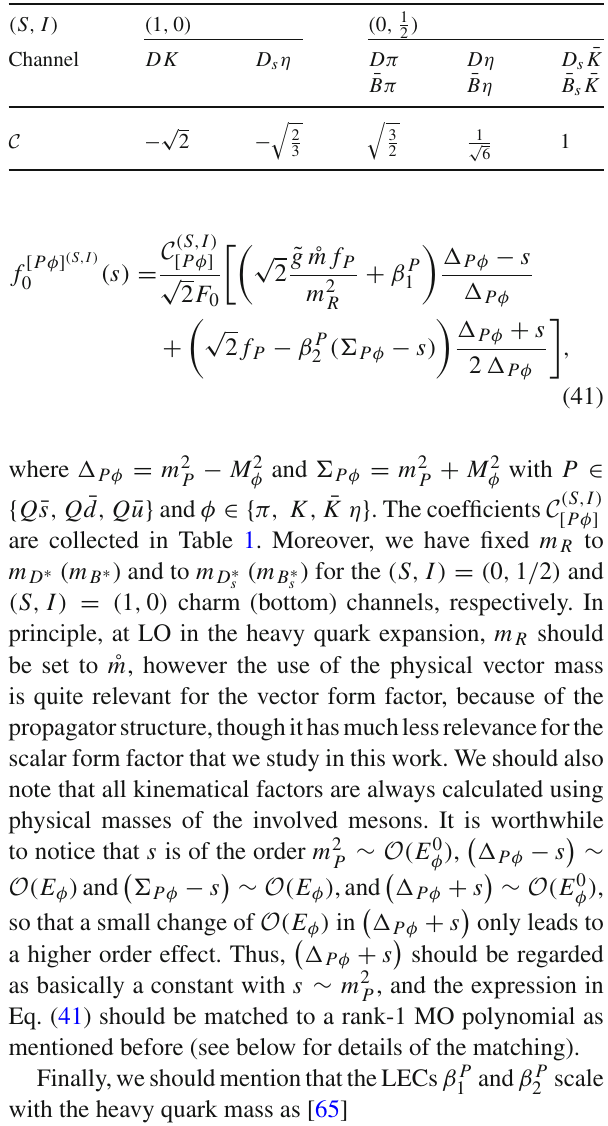
Fig. 7 Topologies of the relevant Feynman diagrams contributing to the hadronic matrix elements. The solid circle denotes the LO PP ∗ φ interaction and the solid square represents the left-handed current Table1 Strangeness-isospincoefficientsappearinginthechiralexpan- sion of the form